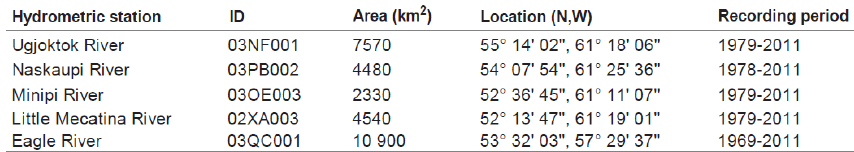
Table 2. Description of hydrometric stations used in this